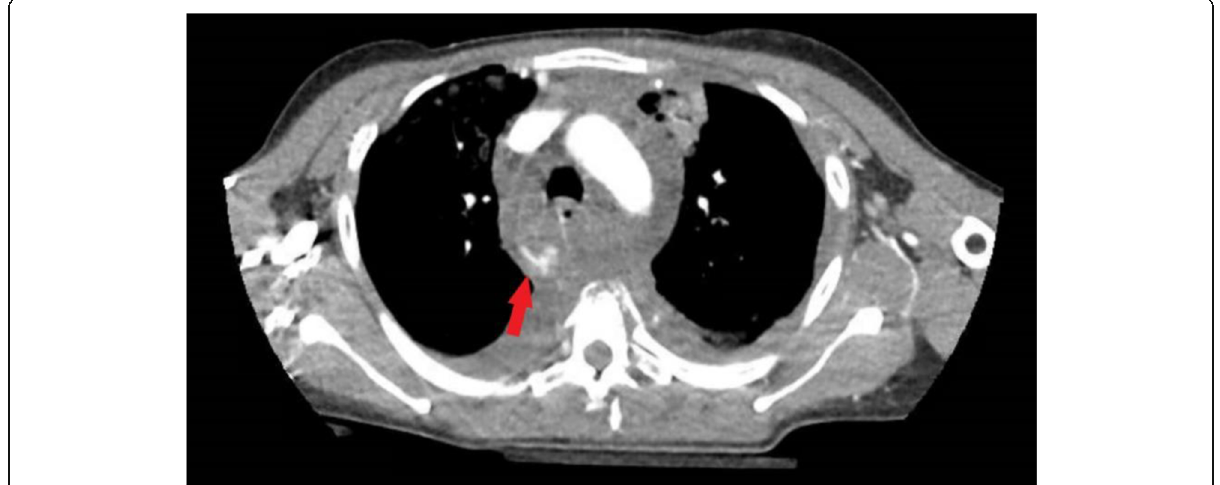
Fig. 1 Axial CT slice through the azygous venous arch showing active extravasation of contrast (arrow) from the inferior aspect of the